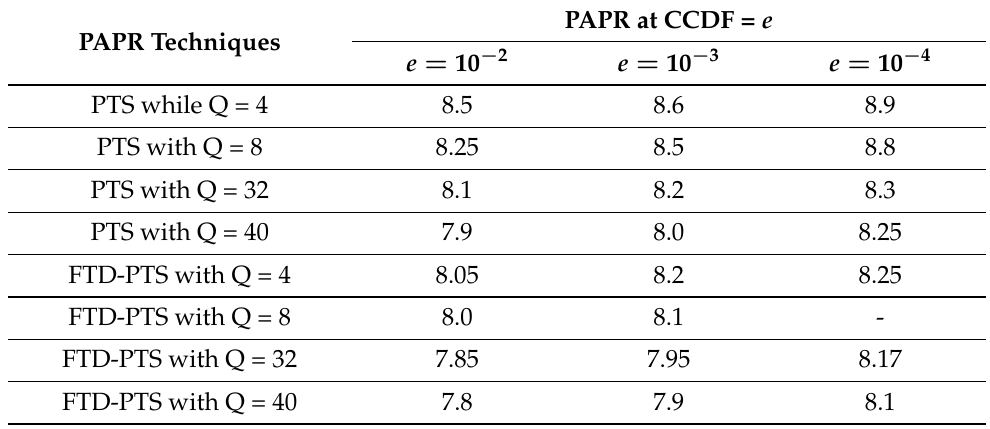
Table 5. PAPR reduction performance of PTS with different Q and FTD-PTS.